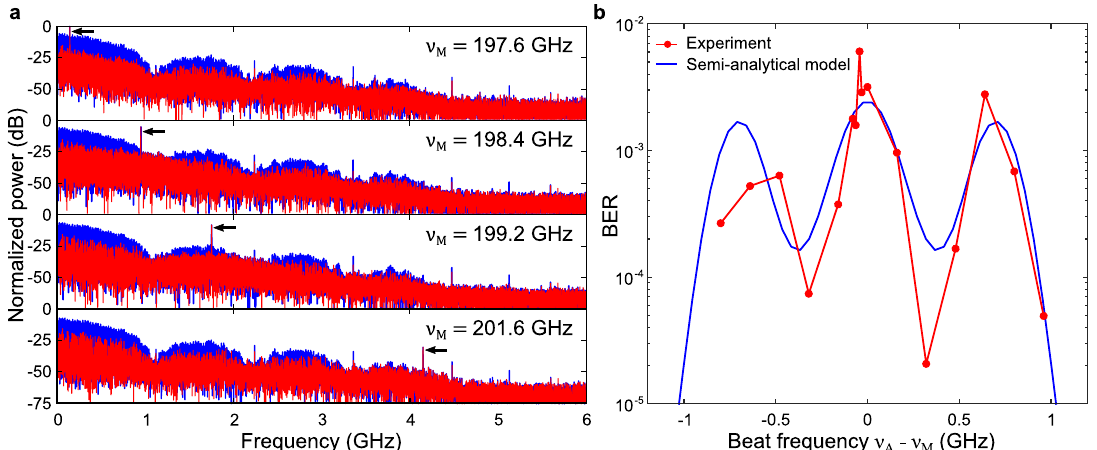
Fig. 5 Beat jamming. a The received spectrum (blue) and the difference between the jammed signal and Alice ’ s signal (red) are shown, for four different values of Mallory ’ s single-tone frequency, ν M . As Mallory ’ s frequency increases, the interference signal and beat signal location (shown with the arrow) on the spectrum increase as well. b Measured BER (red dots) as a function of the difference in frequency between Alice and Mallory ( ν A (cid:2) ν M ). The observed oscillatory behavior can be modeled (blue line) using a simple description of the SINR (Eq. 5) and the BER fi t of Fig. 4. Here, we used A a = 1, A m = 0.17 for the amplitudes, SINR ¼ 19dB in the absence of interference, and T ¼ 0 : 8929ns, which corresponds to the experimental data rate B ¼ 1 : 12Gbps. In these measurements, Alice ’ s frequency is fi xed at 197.5 GHz.